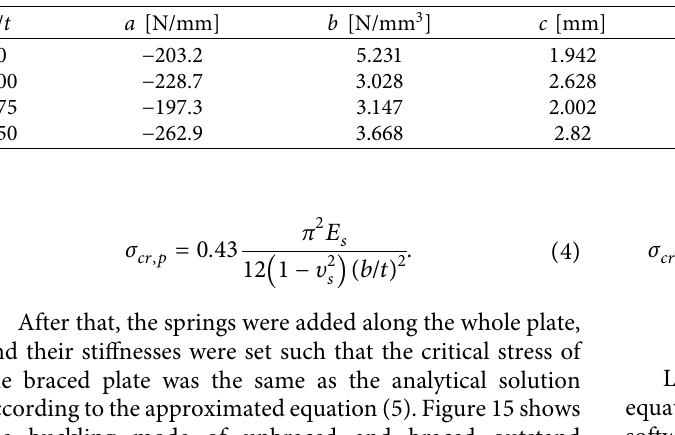
Figure 14: The fitted 3D curve of K as a function of E � 175) and (b) outstand plate ( b / t � 50). c and A : (a) internal plate ( b / t Table 5: Coefficient of equation (3) of internal compressed